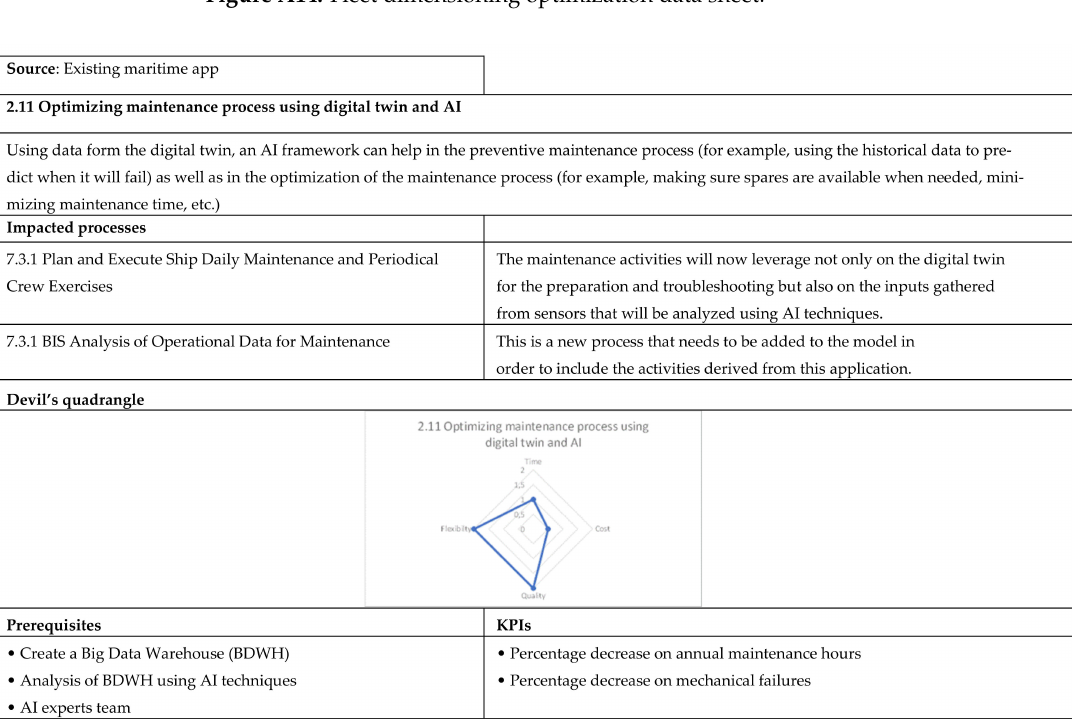
Figure A15. Optimizing maintenance process using digital twin and AI data